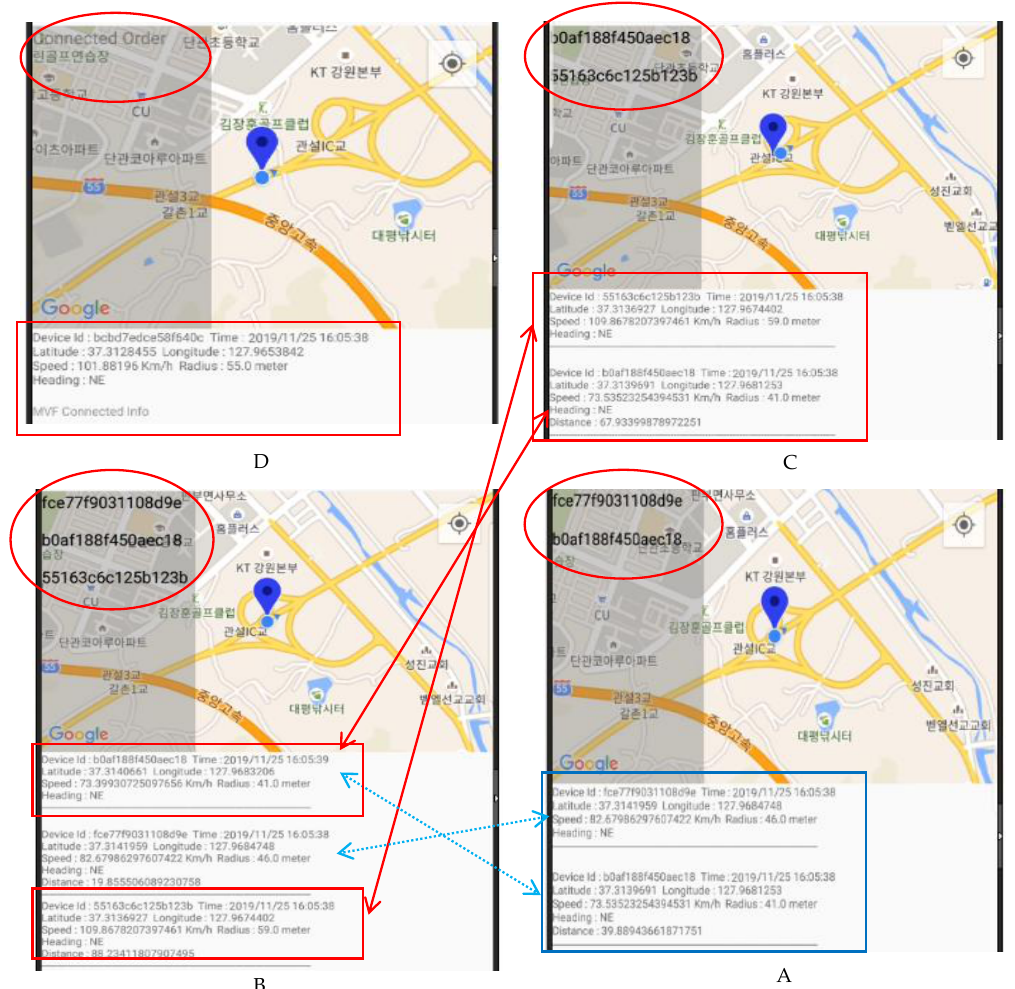
Figure 9. Screen images of the connected group’s reformation and overtaking.